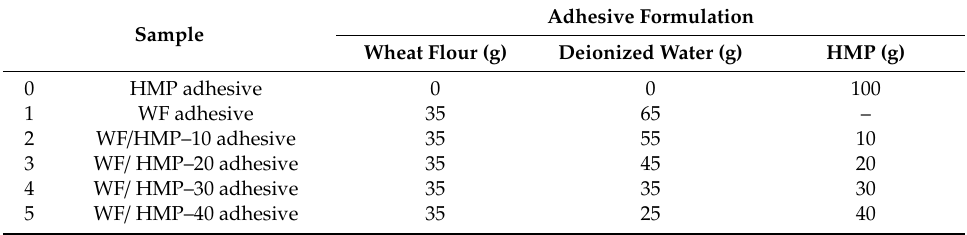
Table 1. Different wheat flour (WF) / hydroxymethyl melamine prepolymer (HMP) adhesive